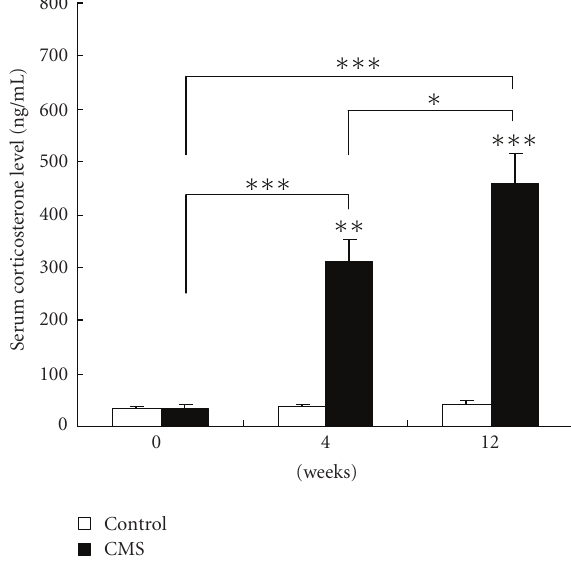
Figure 3: Serum corticosterone levels in CMS and control groups following at di ff erent weeks of CMS ( n = 20 per group). Serum cor- ticosterone concentrations were assayed using a radioimmunoassay (RIA). Corticosterone levels were higher in the CMS group versus the control group. Data are mean ± SEM. ∗ P < . 05, ∗∗ P < . 05, ∗∗∗ P < . 001 versus respective control